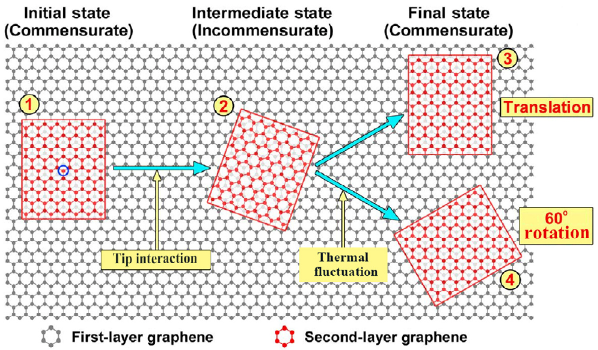
Fig. 2 Conversion process of commensurate-incommensurate state when graphene nanosheets slide on graphene surface. Reproduced with permission from Ref. [53], © American Chemical Society